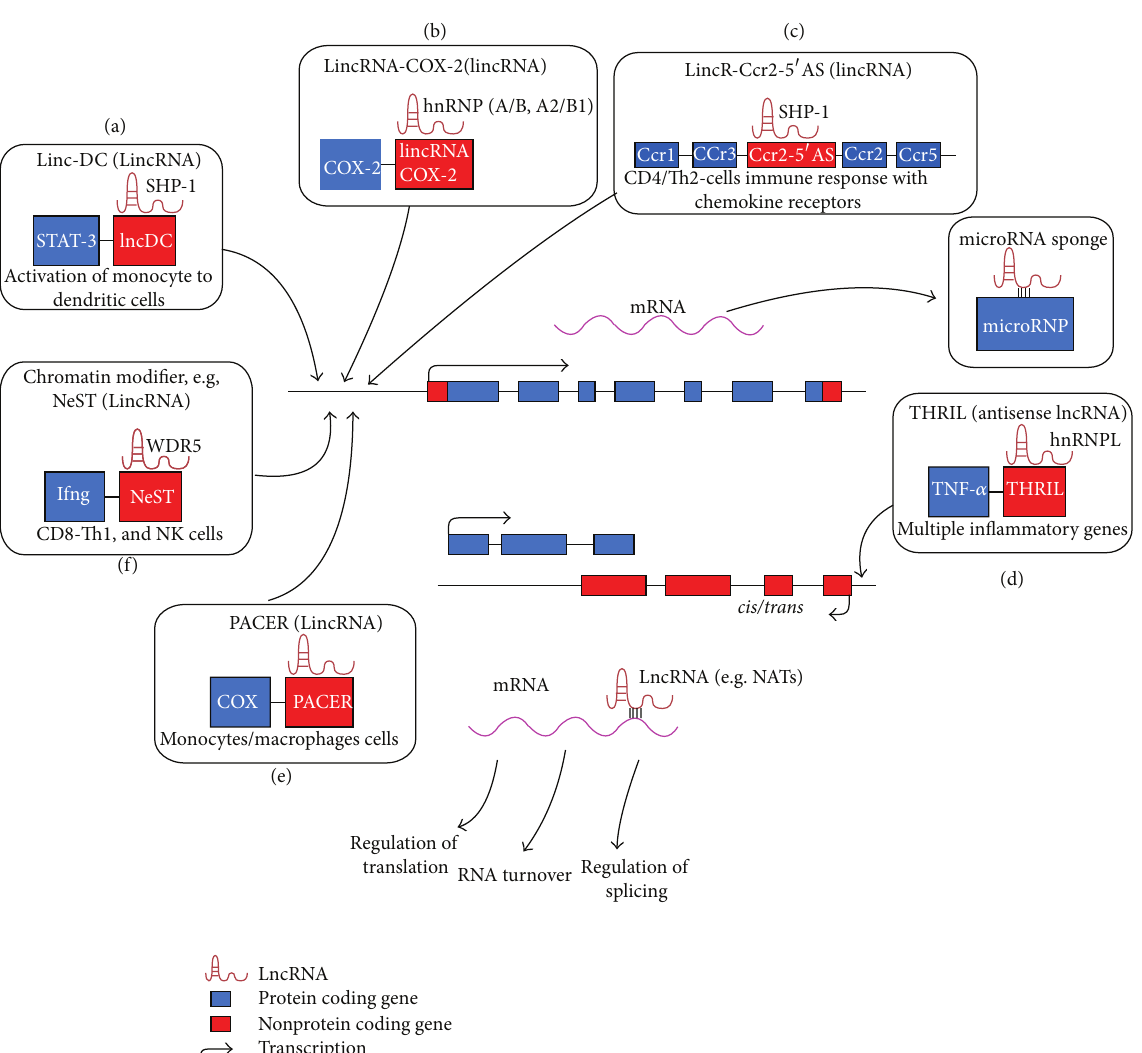
Figure 2: The functions of lncRNAs in autoimmune cells, T cells, B cells, macrophages, NK, and dendritic cells. (a) Lnc-DC expression is needed for differentiation of human monocytes into dendritic cells. Lnc-DC promotes STAT3 phosphorylation through inhibiting the action of Src homology region 2 domain-containing phosphatase-1 (SHP-1) [18]. (b) LincRNA-COX-2 is located in COX2 gene in mouse bone marrow-derived macrophages. It has extensive effects on inflammatory gene expression, repressing the transcription of